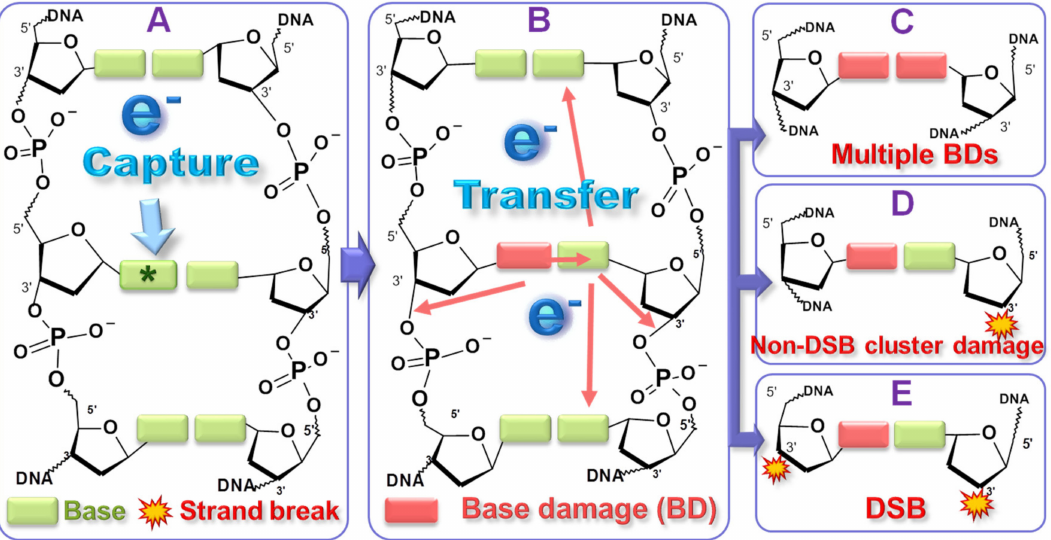
Scheme 1. Diagram of the reaction pathways for a single LEE to produce all possible types of double-lesion cluster DNA damage. Possible electron transfer sites are indicated by red arrows. The electron (e-) is initially captured by a base, forming a core-excited transient anion ( A ). An electron autodetaches from the base anion, leaving the base in a dissociative state ( B ). The base is damaged and the detached electron transfers to other sites where DEA occurs ( B ). Transfer to the opposite base can result in two adjacent BDs ( C ), whereas transfer to the phosphate unit in the same or opposite strand, can cause a strand break via C − O bond breakage (SSB via DEA + BD) ( D ) or a DSB, if the BD on the left strand is converted to a strand break ( E ). Electron hopping between bases can create a BD or SSB farther away from the initial electron capture